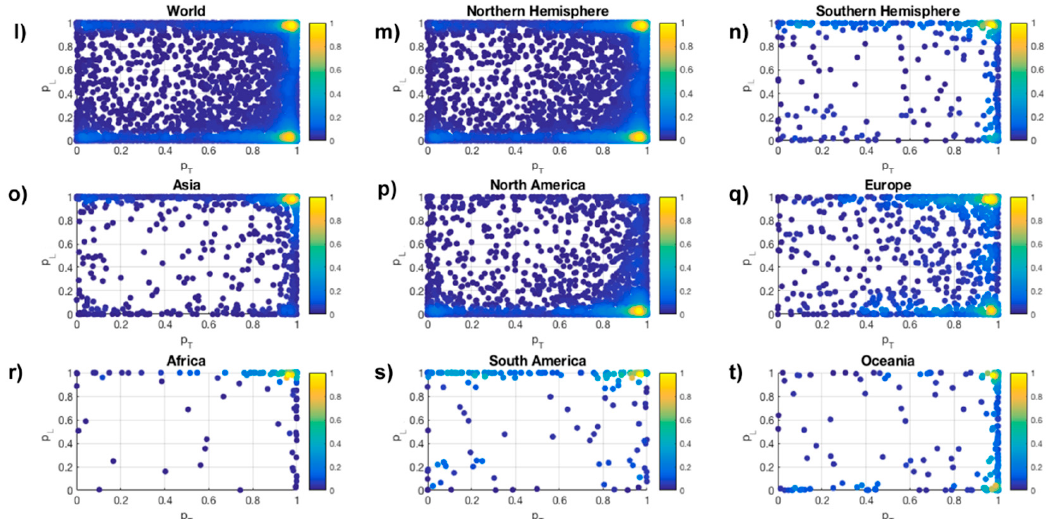
Figure 5. Slope and P value scatterplots of T and L regression trend lines at global and continental scales, 3 × 3 km buffer. Panels ( a – i ): slope of T ( b T ) and L ( b L ) regression trend lines. The number of stations included in each sector is in bold, as well as the number of stations with L systematically equal to zero ( b L = 0) on the horizontal axis. Panels ( l – t ): p values density plots where the color scale represents the data density. Figure 5l–t show the joint distribution of p T and p L values, which is represented as density plots. Similar conclusions shown above can be drawn at the continental scale, with the majority of the p values in the upper-right corner (very large p values) for Asia, Africa, and South America (weaker signal), which implies a systematic presence of concordant increasing trends of nightlights and temperature. Europe and Oceania have a bimodal distribution, with a second high-density peak in the lower-right corner (increasing temperature with decreasing nightlights). Lastly, North America presents a clear concentration of data points in the lower-right corner of the diagram, which indicates increasing temperature trends and decreasing nightlights trends.